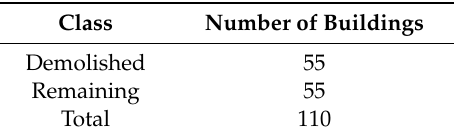
Table 2. Number of demolished and remaining buildings in the training dataset in the Mashiki building map data.